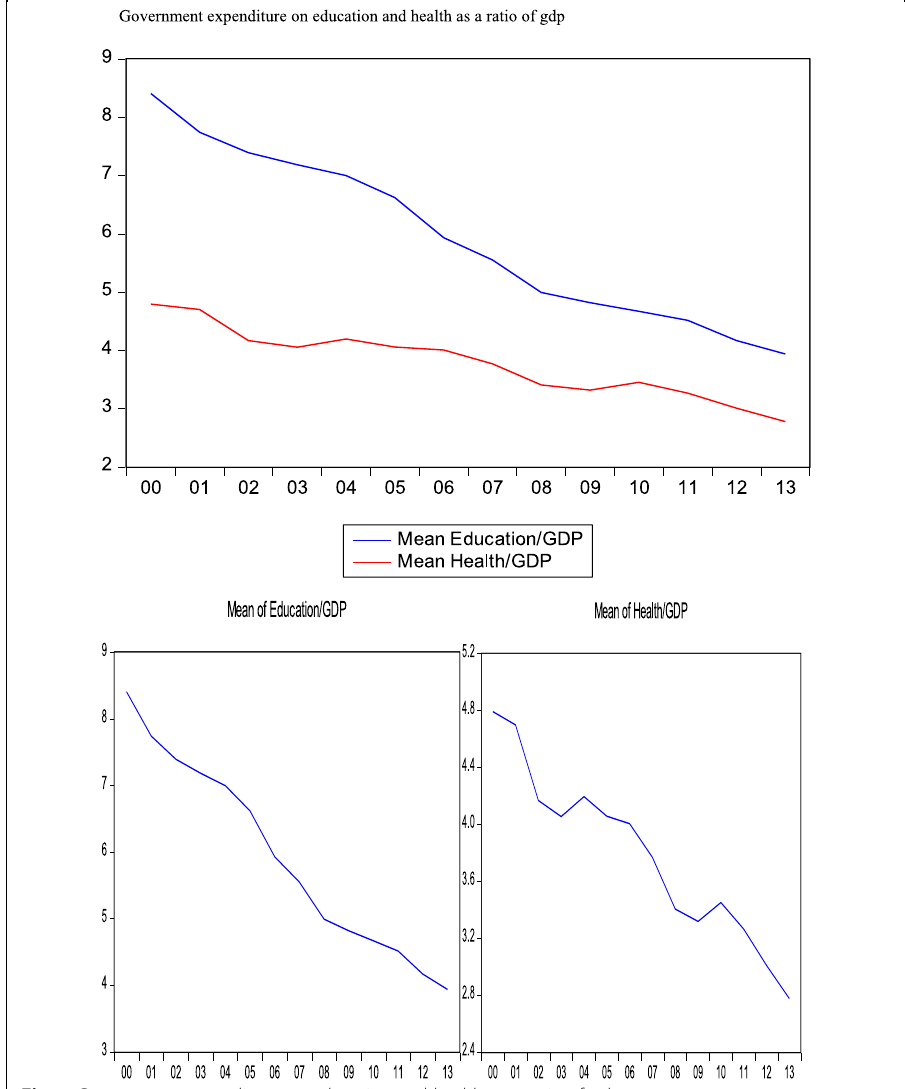
Fig. 5 Government expenditure on education and health as a ratio of